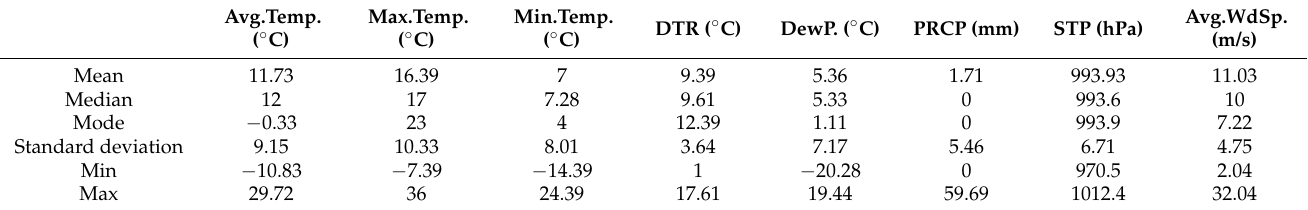
Table 2. Local climatological data of P é cs in 2017. (Abbreviation: Avg.Temp.: average temperature, Max.Temp.: maximum temperature, Min.Temp.: minimum temperature, DTR: diurnal temperature range, Dew.P.: dew point, PRCP: precipitation, STP: station-level air pressure, Avg.WdSp.: average wind speed).